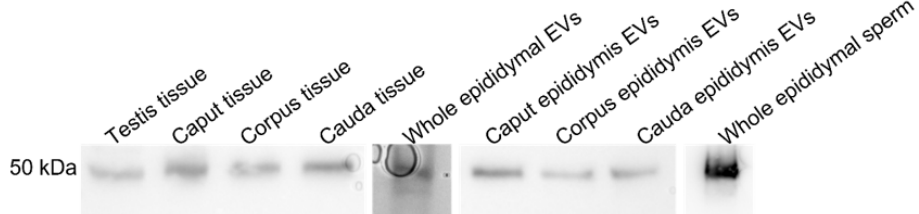
Figure 5. LGALS3BP detection using Western blot analysis in testicular tissues (n = 5 males), epididymal tissue (n = 5 males); pooled samples of EVs (n = 5 replicates; pools of 5 males each); epididymal EVs from caput, corpus, and cauda of the epididymis (n = 5 males); pooled samples of sperm cells from whole epididymis (n = 6 males).